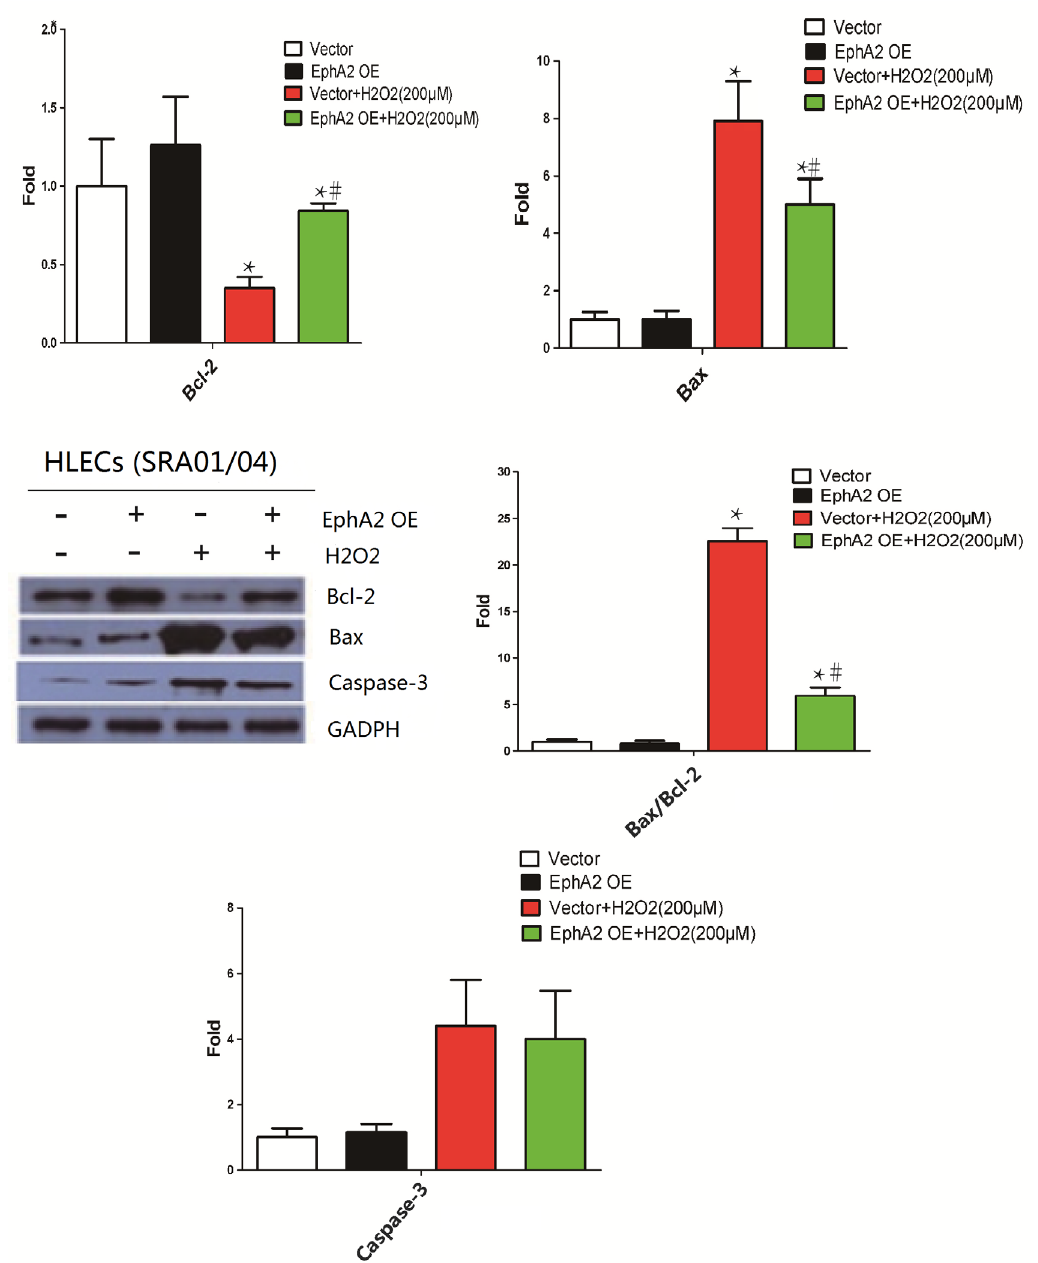
O -treated SRA01/04 cells. SRA01/04 cells were 2 2 O for 24 h. WB was performed to examine 2 2 O 2 2